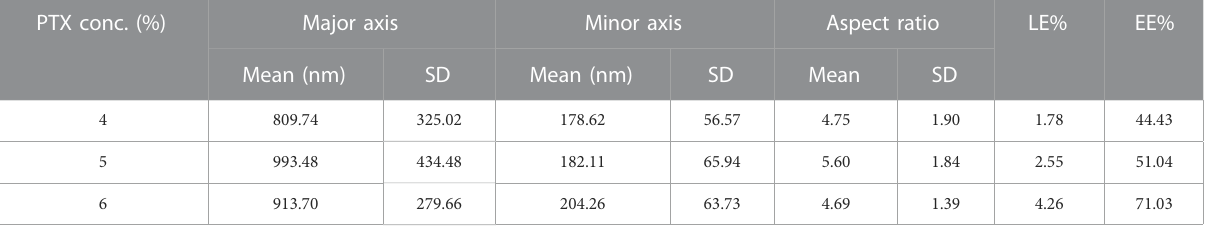
TABLE 2 Characterization of the paclitaxel-loaded PLGA nanorods prepared with different PTX concentration. PTX conc.